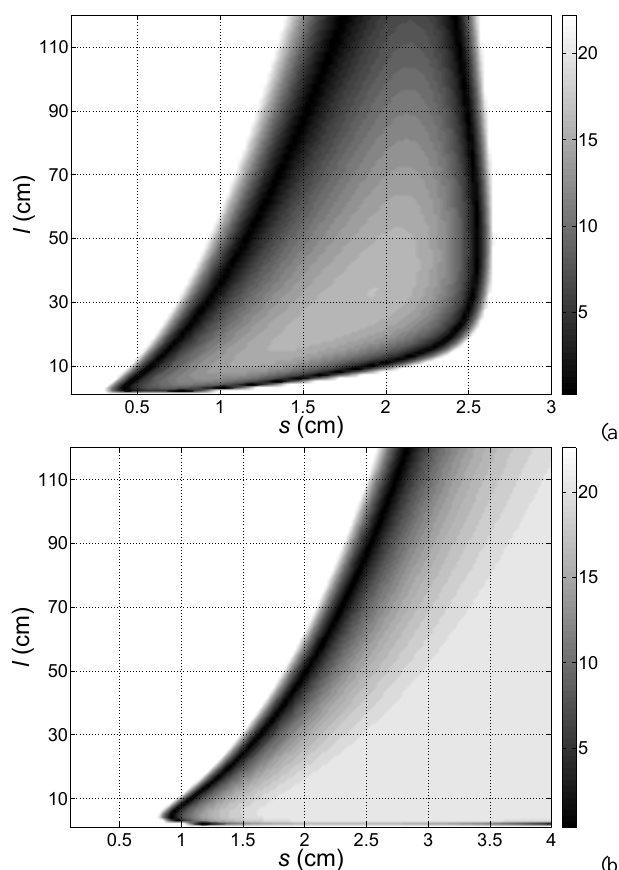
Fig. 2. Absolute soil moisture retrieval error (vol%) for differ- ent ( s , l )-combinations and a given ( σ 0 , M v )-observation using (a) C-band HH (RADARSAT-1 acquisition of La Tejer´ıa, with σ 0 = − 5 . 93dB and M v = 22 . 76vol%) and (b) L-band HH (E-SAR ac- quisition of Demmin, with σ 0 =− 17 . 55dB and M v = 22 . 34 vol%).